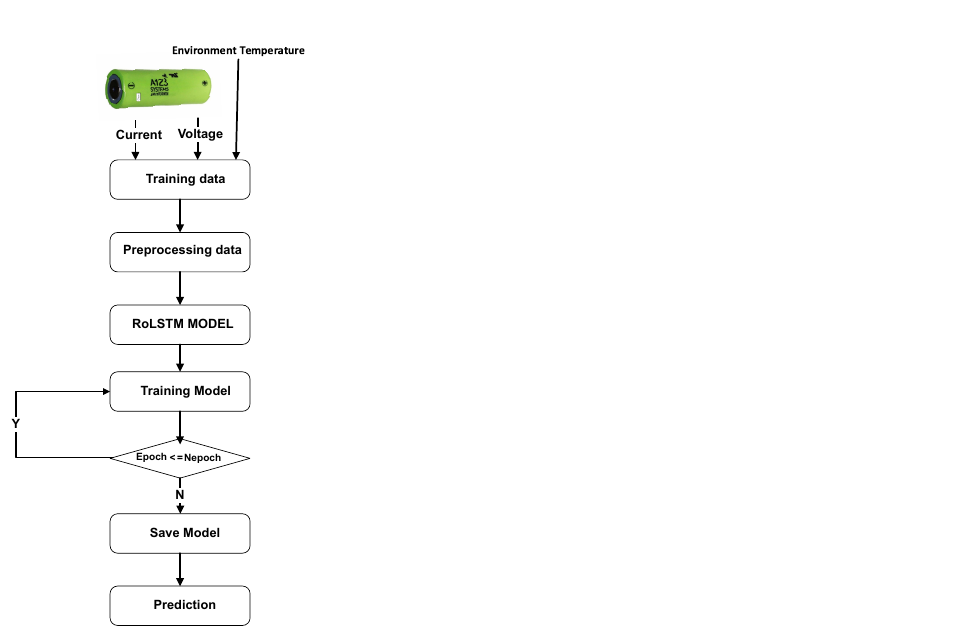
Figure 4. The flowchart of RoLSTM programming for SOC estimation.